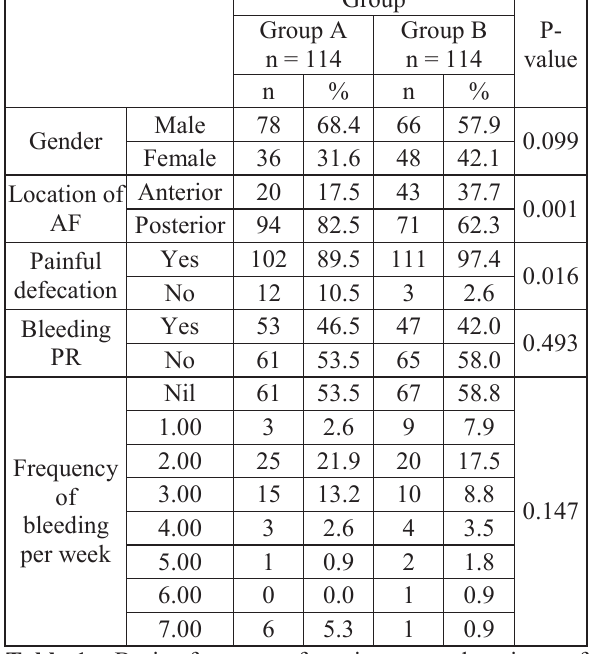
Table-1: Basic features of patients at the time of